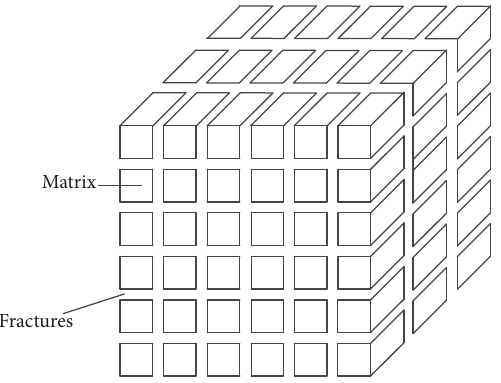
Figure 4: Sketch of the Warren-Root Model [24].